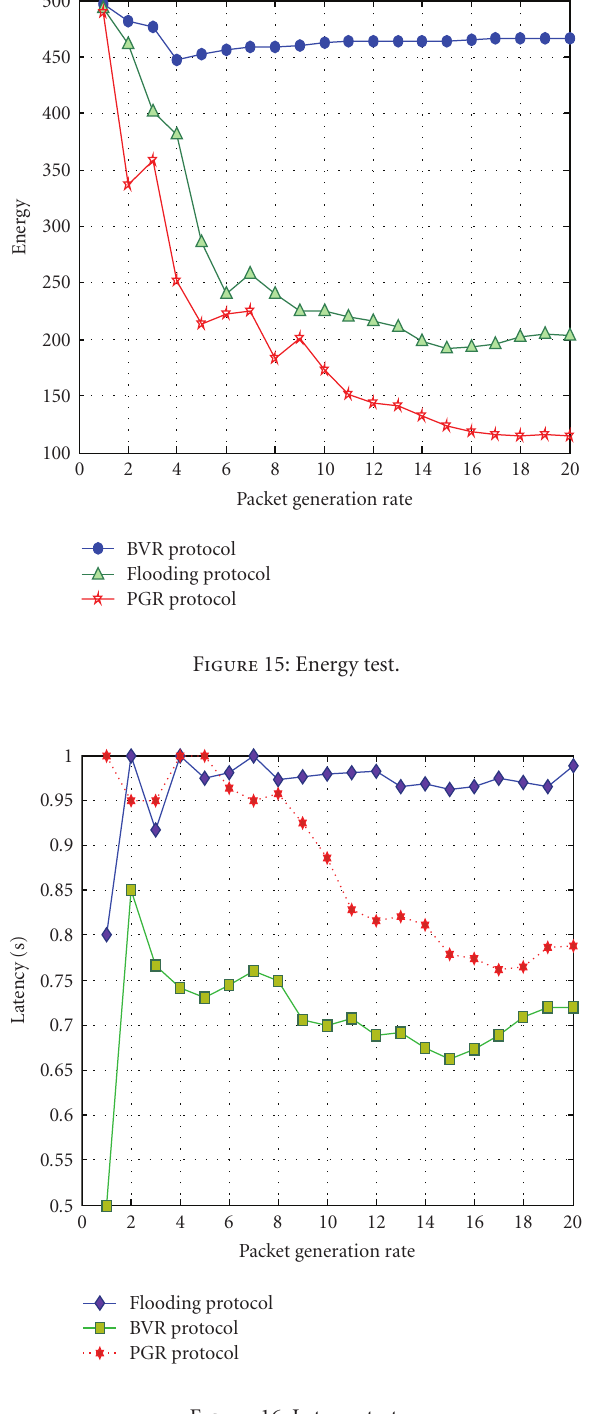
Figure 16: Latency test.